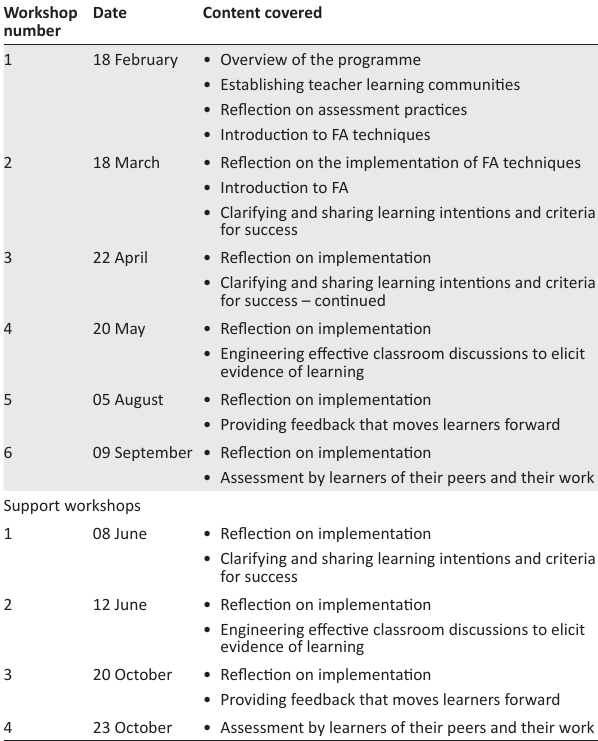
TABLE 1: The Assessment for Learning in Africa professional development workshop dates and